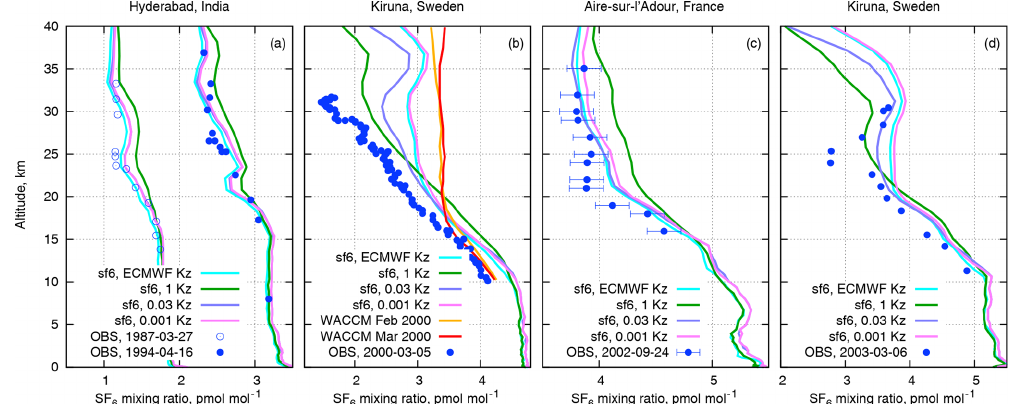
Figure 5. Observed SF 6 balloon profiles and corresponding daily-mean SILAM profiles for the date of observations. The observational data obtained from Patra et al. (1997), Ray et al. (2014, 2017), and Engel et al. (2006) are for (a) – (d) correspondingly. The observation uncertainties are about 2% (1 σ ) for Hyderabad profiles (a) and smaller than the size of the symbol for Kiruna profiles (b, d) . The model profiles from the WACCM model are from Ray et al.